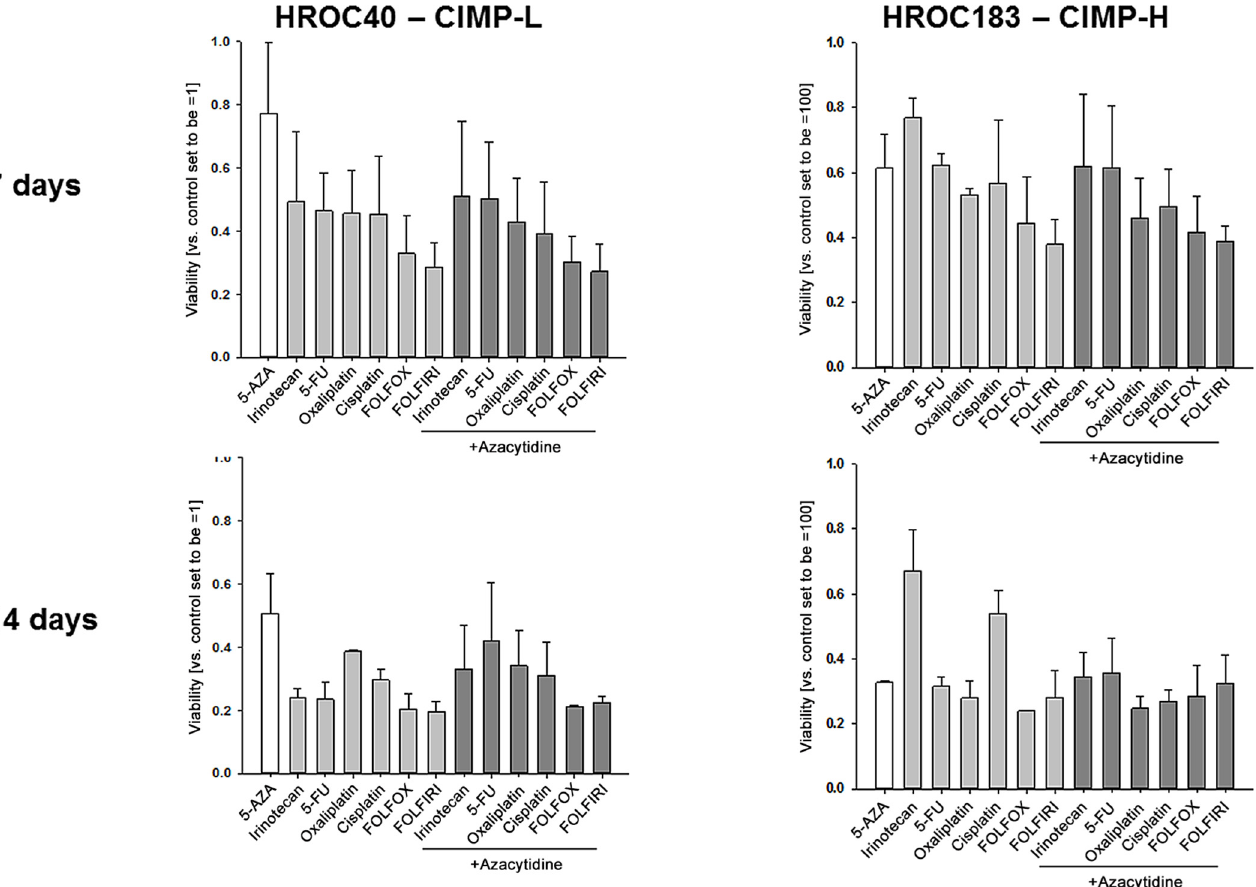
Fig 6. Response to Aza-based drug combinations. Representative quantitative analysis of HROC40 (left graph) and HROC183 cells (right graph) treated with Aza, standard drugs or combinations thereof. Cells received two (upper panel) or four (lower panel) treatment cycles in concentrations as indicated in the material and methods section. Cytotoxicity was quantified upon crystal violet staining and measurement at 570 nm (reference wavelength: 620 nm). Results show the mean + standard deviation of three independent